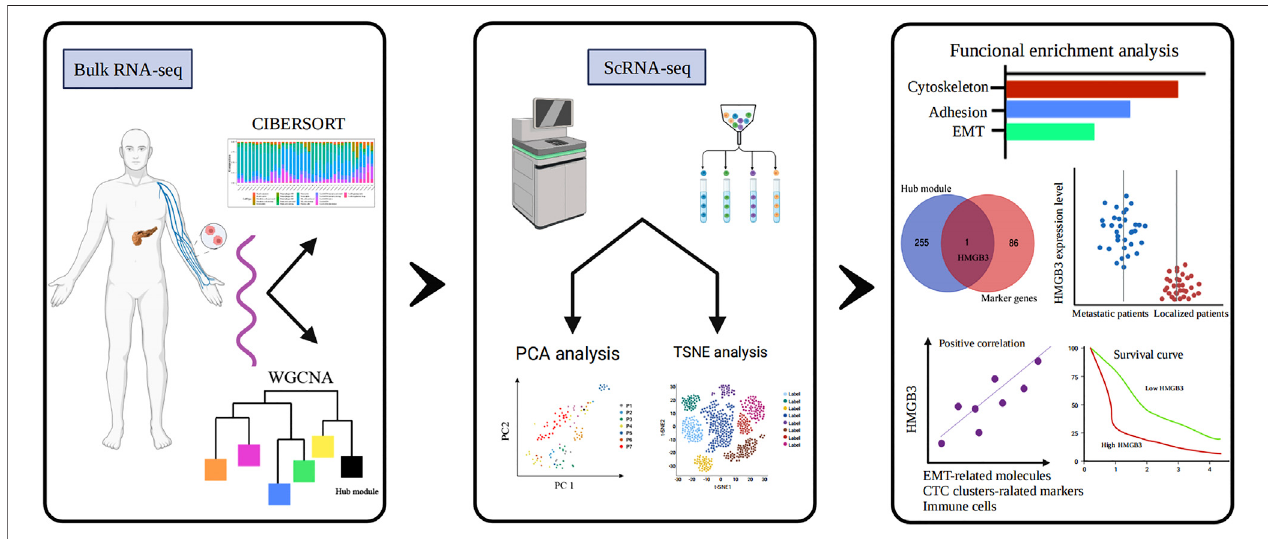
FIGURE 1 | Study fl ow diagram. WGCNA, weighted gene co-expression network analysis; PCA, principal component analysis; TSNE, T-stochastic neighbor embedding; HMGB3, high-mobility group box